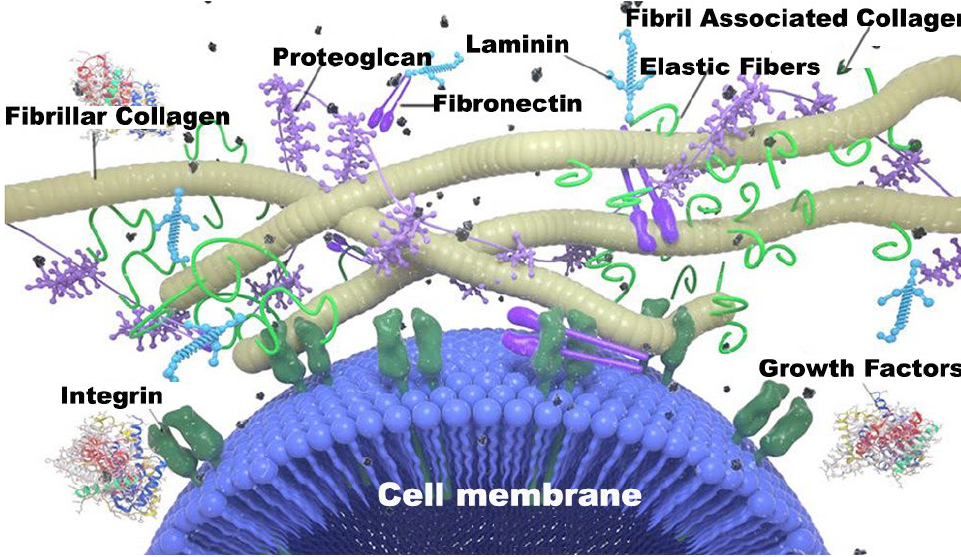
Figure 2. Representative illustration of extracellular matrix (ECM) compositional layout indicating cellular engagement with ECM biomolecules and primary components of general ECM space [28].